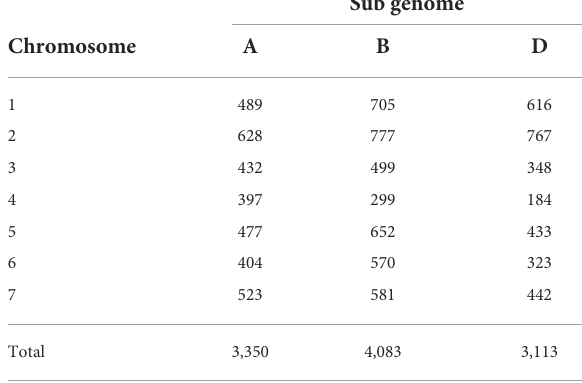
TABLE 3 Chromosome wise distribution of SNP markers on the three sub genomes of